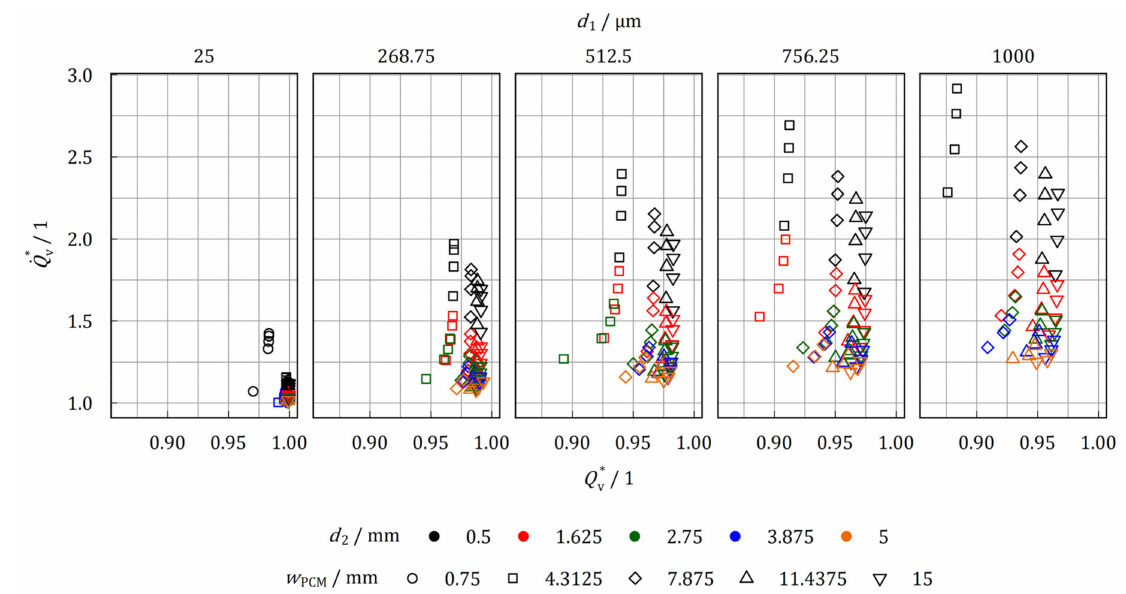
Figure 19. Ratio of mean volume specific power vs. ratio of volume specific storage capacity for all variations of the wire cloth to tube bundle heat exchanger in dependency of wire diameter d 1 , tube diameter d 2 and the heat exchanger distance w PCM for stainless steel as